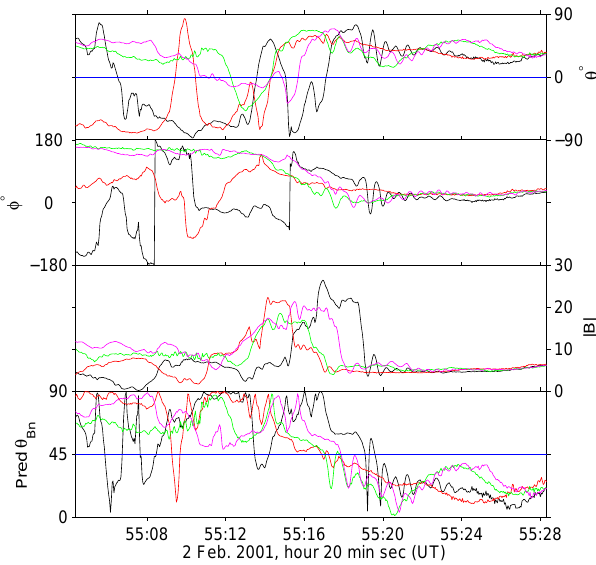
Fig. 5. Magnetic field data from the four spacecraft at 22 vectors/s showing magnetic field magnitude enhancements within a pulsation region. The format of the figure is as in Fig. 4.